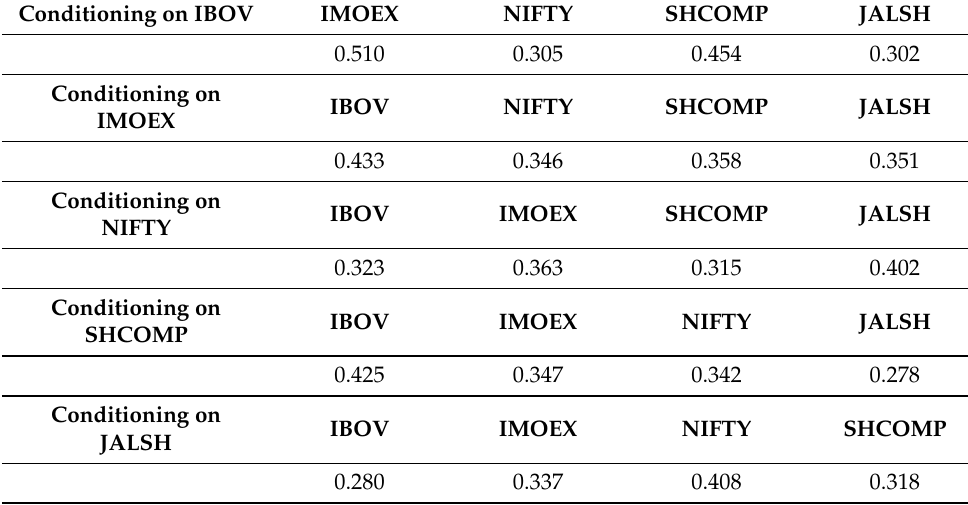
Table 4. Predicted conditional probability of threshold exceedance.